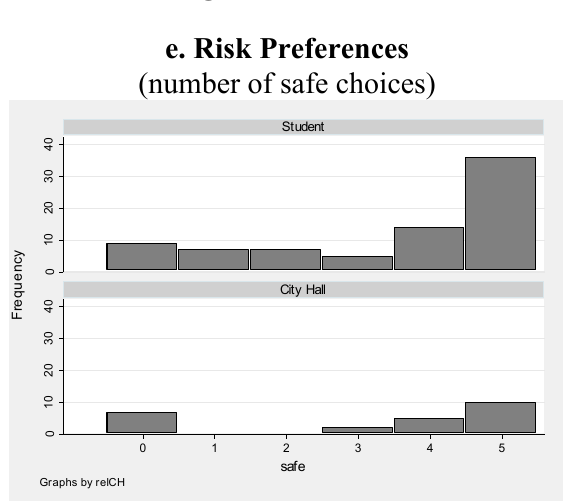
Figure A.1. Cont.